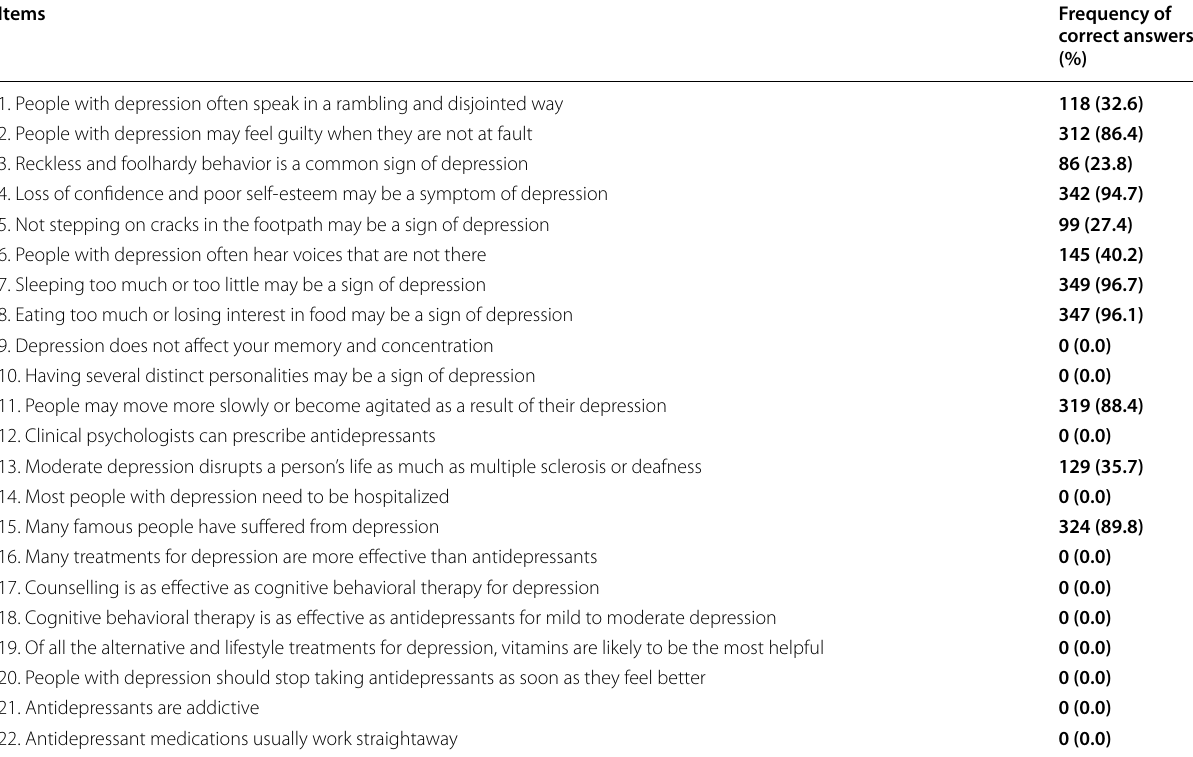
Table 2 Frequency distribution of correct answers to the depression literacy scale